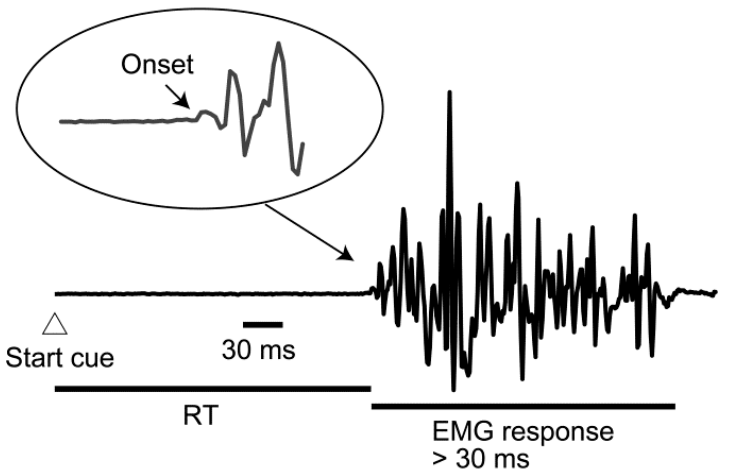
Figure 1. Time protocol of eight trial blocks ( A ) and four trial sets in which each set involves the eight trial blocks ( B ). Ten practice trials are followed by six successful test trials for a trial block ( A ). One of the eight tasks is randomly assigned in each trial block. This trial block is conducted for the eight tasks in each trial set. The trial set is repeated four times ( B ).